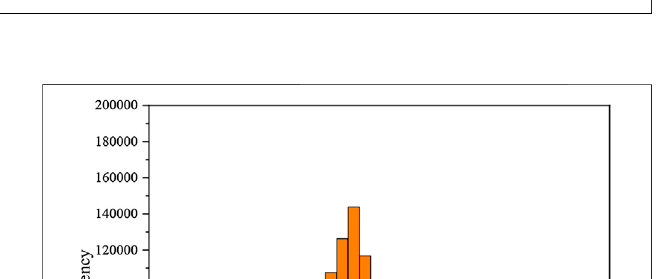
FIGURE 11 | Meshing model for 19-pin wire-wrapped fuel assembly.